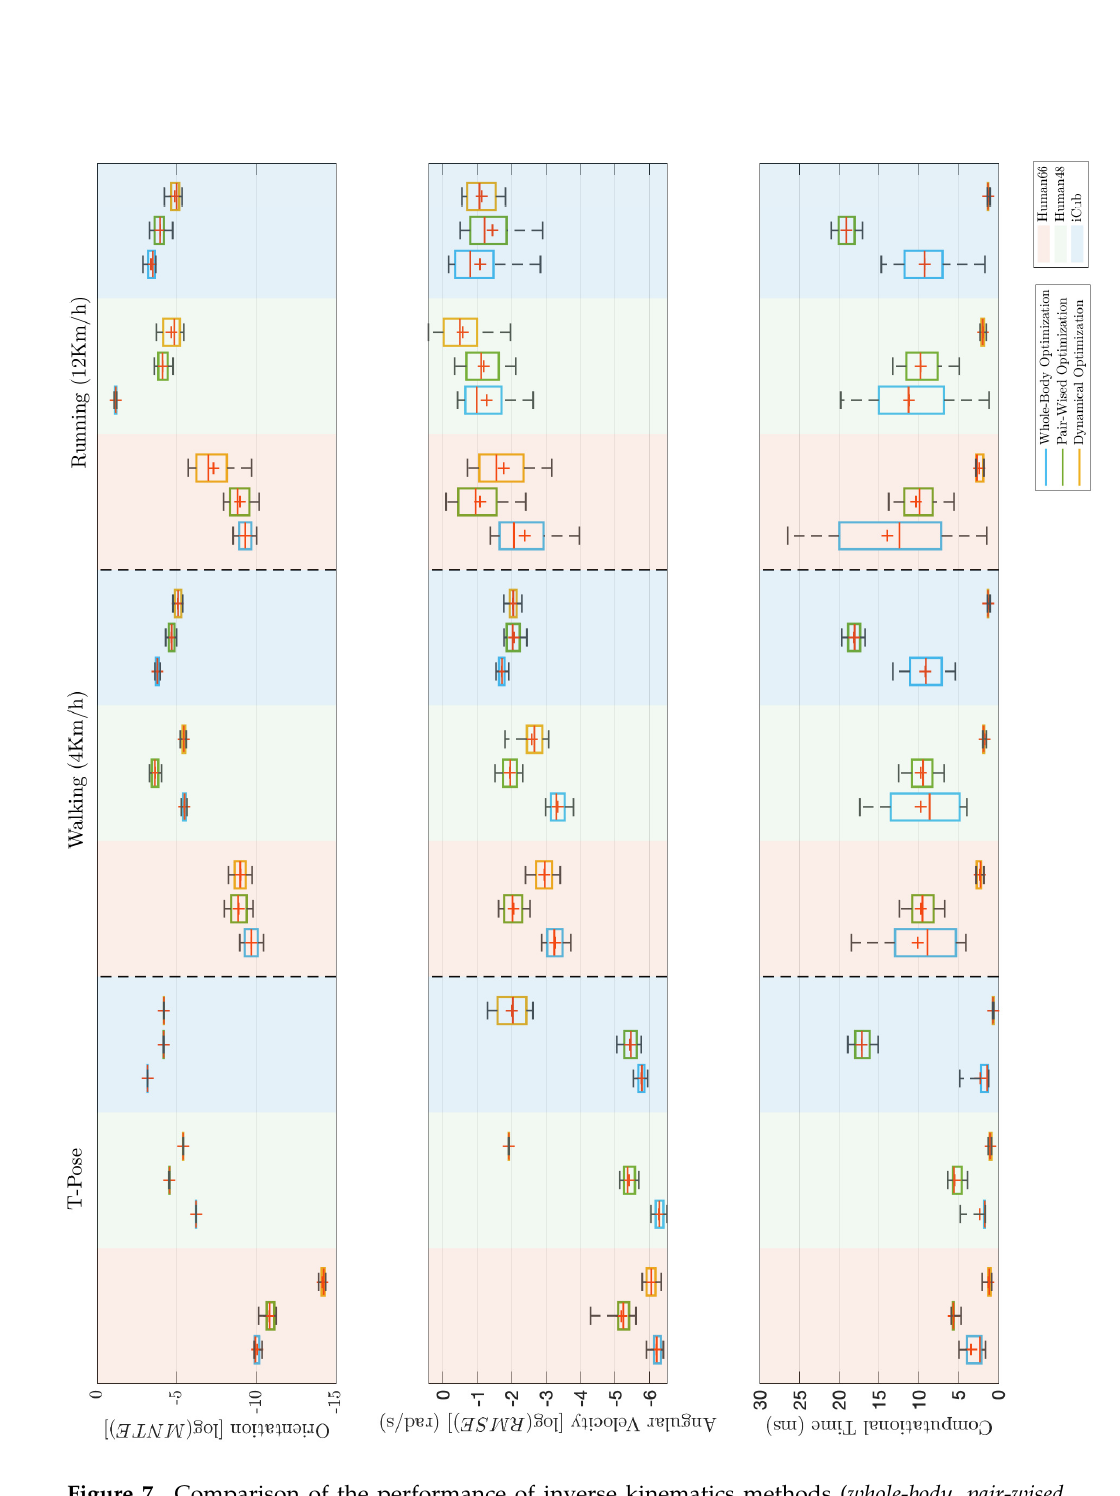
Figure 7. Comparison of the performance of inverse kinematics methods ( whole-body , pair-wised , and dynamical ) for three models (two humans, and iCub humanoid) in three different scenarios ( T-pose , Walking , and Running ). Each line contains the boxplots for a different performance evaluation metric, on the top the overall error for the orientation targets as base 10 logarithm of mean normalized trace error , in the middle line the overall error for the angular velocities as base 10 logarithm of root mean squared error , and at the bottom the computational time. Logarithmic metrics allows to compare metrics characterized by different order of magnitude in the different